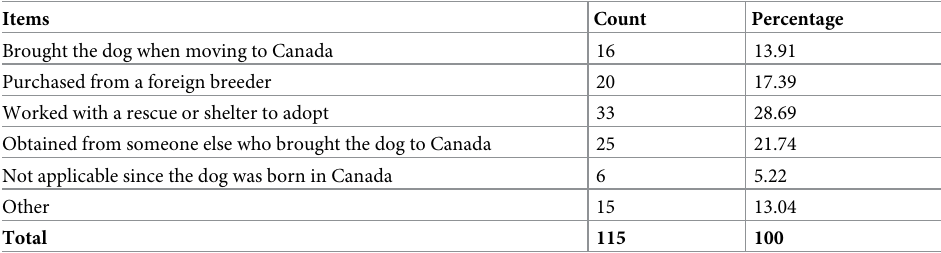
Table 18. Non-Canadian dog